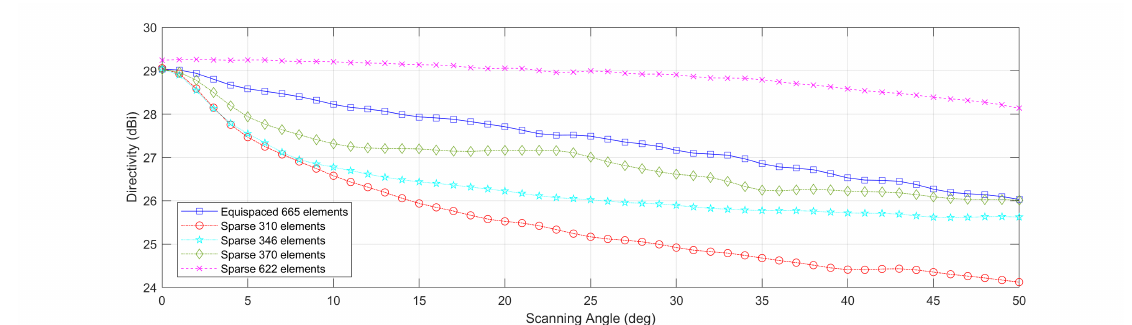
Figure 10. Directivity as a function of the focusing angle for some of the synthesized array